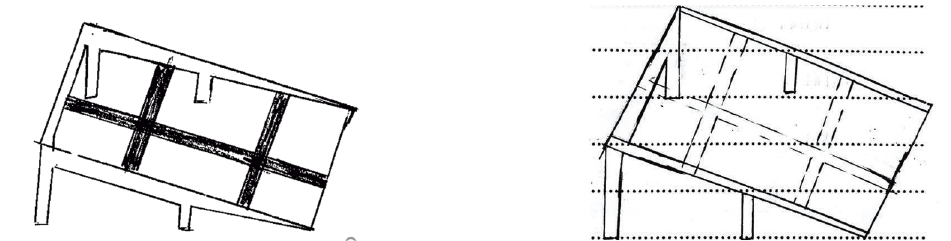
Figure 5b. The design of the ramp of Group 2